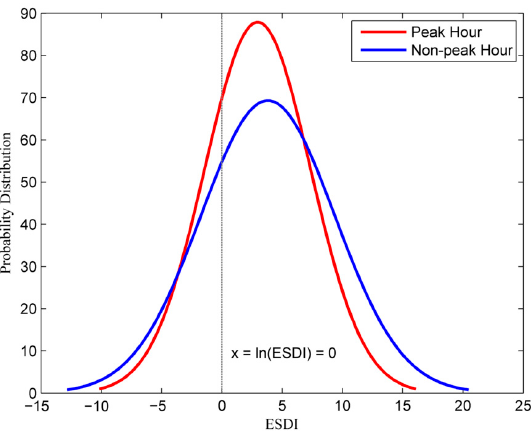
Figure 8. Normal distribution curve of ESDI.